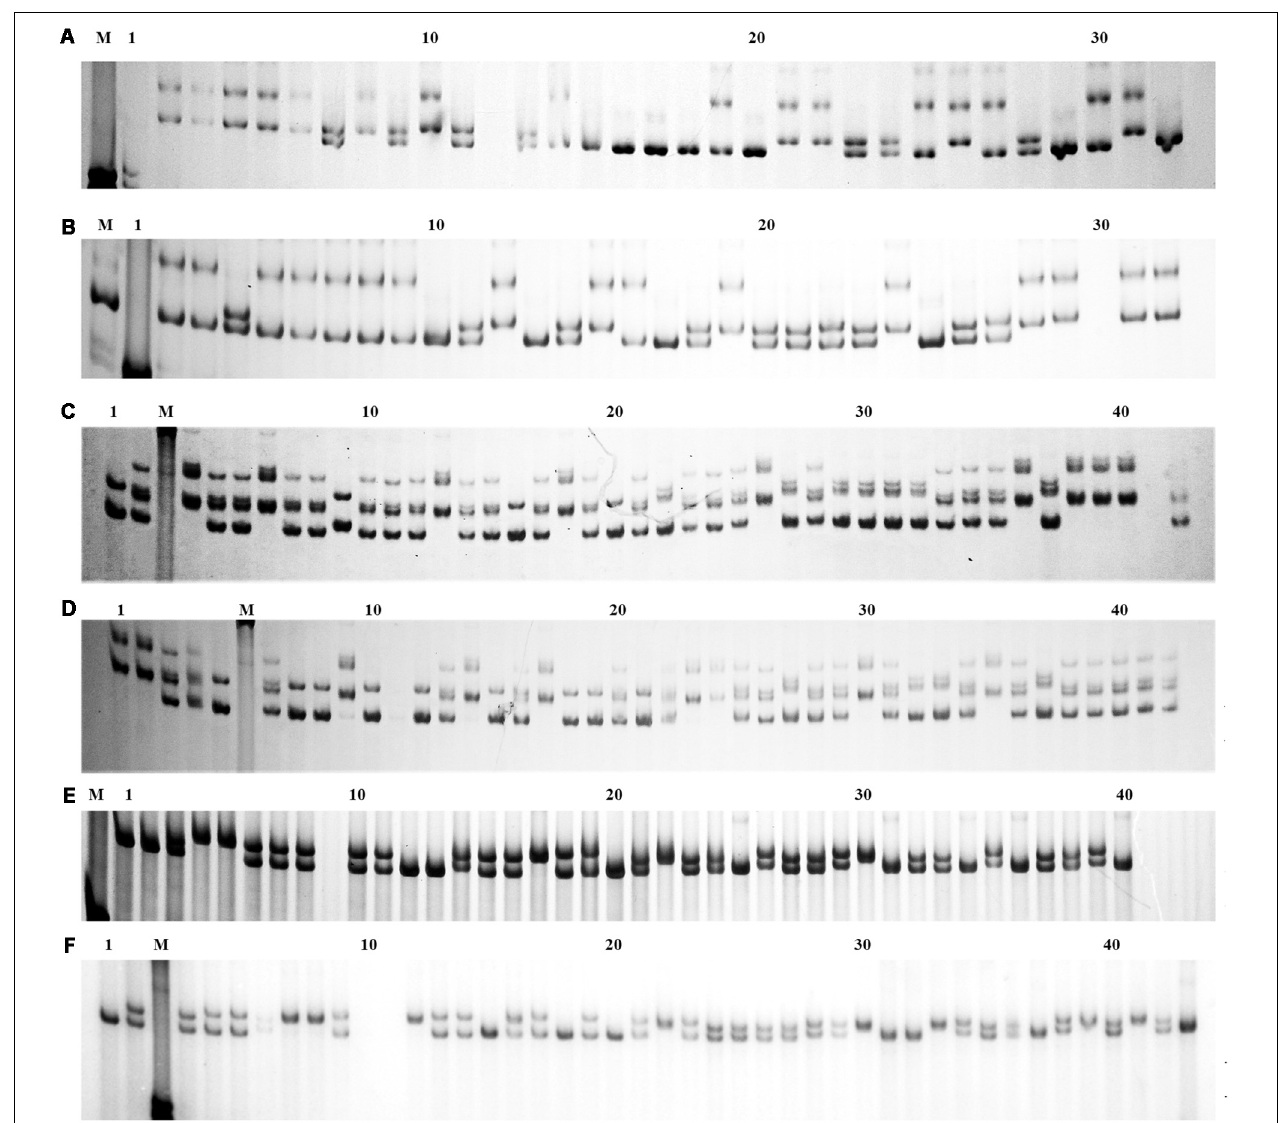
FIGURE 4 | The electrophoresis patterns of some primers in 2n and 4n populations. M, DNA 2000 plus maker. (A) Locus Smac-05 in 2n populations; (B) Locus Smac-05 in 4n populations; (C) Locus Sma3-129INRA in 2n populations; (D) Locus Sma3-129INRA in 4n populations; (E) Locus Sma-USC23 in 2n populations; (F) Locus Sma-USC23 in 4n